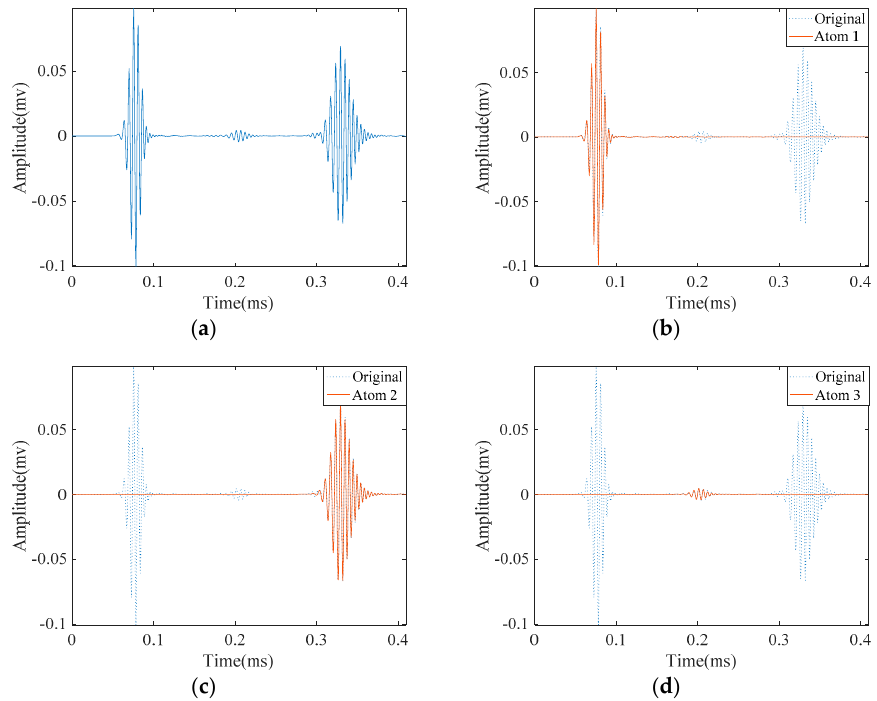
Figure 7. Schematic diagram of the FEM model representing a pipe with a small notch (crack). Table 2. Parameters that were used for approximation of signals obtained from FEM.